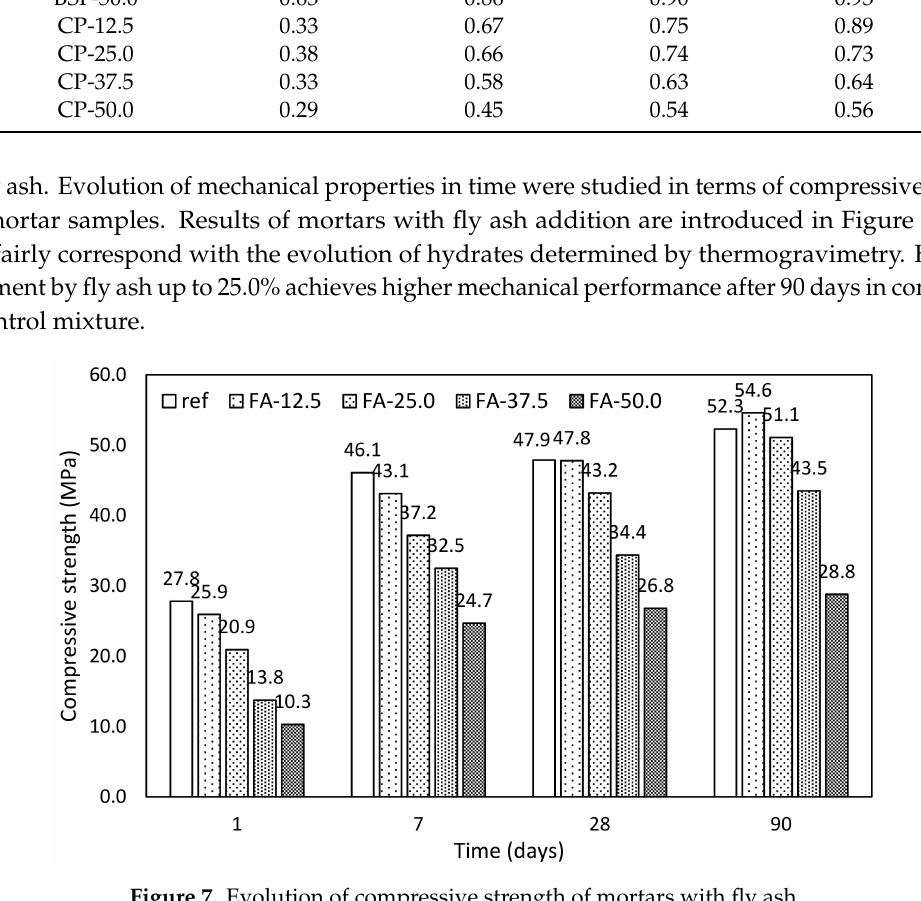
Figure 7. Evolution of compressive strength of mortars with fly